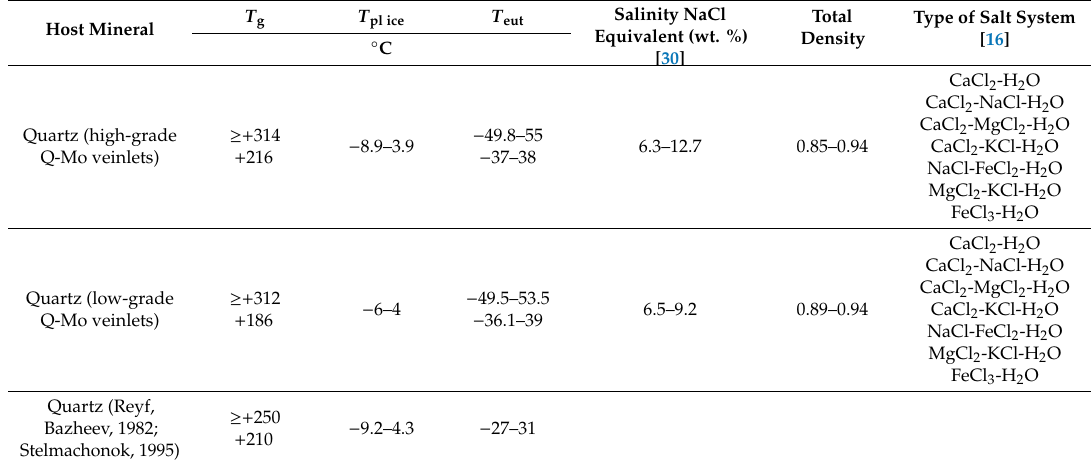
Table 4. Results of the FI study in quartz from the ore veinlets of the Pervomaiskoe deposit. T g T plice Host Mineral